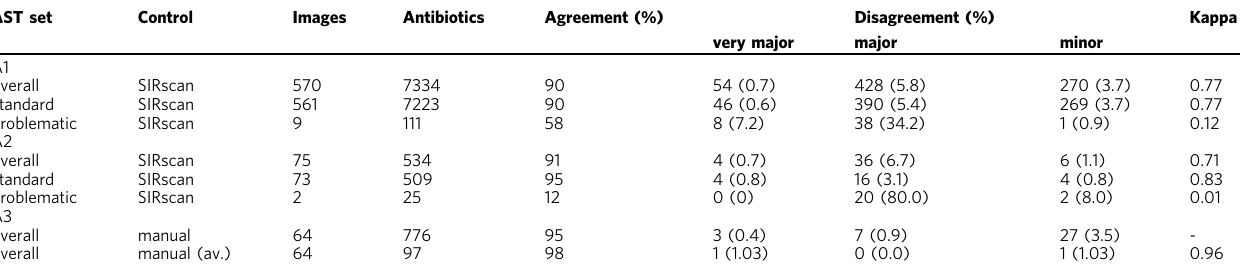
Table 2 Categorization agreement between the App automatic procedure and control. The number of antibiotics reported here is the number of those for which clinical breakpoints are provided by the EUCAST 7 . The lines of this table present the agreement/ disagreement for all antibiogram sets (A1, A2, and A3). For each line, we specify the control of diameter values, the number of analyzed images and corresponding antibiotic pellets, the agreement and disagreement (as de fi ned in the text), the Cohen ’ s Kappa coef fi cient as another measure of agreement. The label “ overall ” means that all pictures are considered, whereas standard and problematic stand for the respective images subsets section. The plates in sets A1 and A3 were grown on a standard Mueller – Hinton (MH) growth medium, whereas we used blood enriched MH in A2. In the last line of the table, the abbreviation av. stands for average. In this line, we used as control diameters the average value across the measurements of all eight